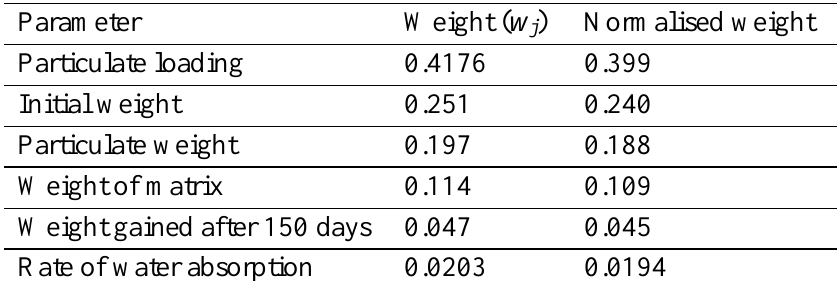
Table 7. Normalised weights of